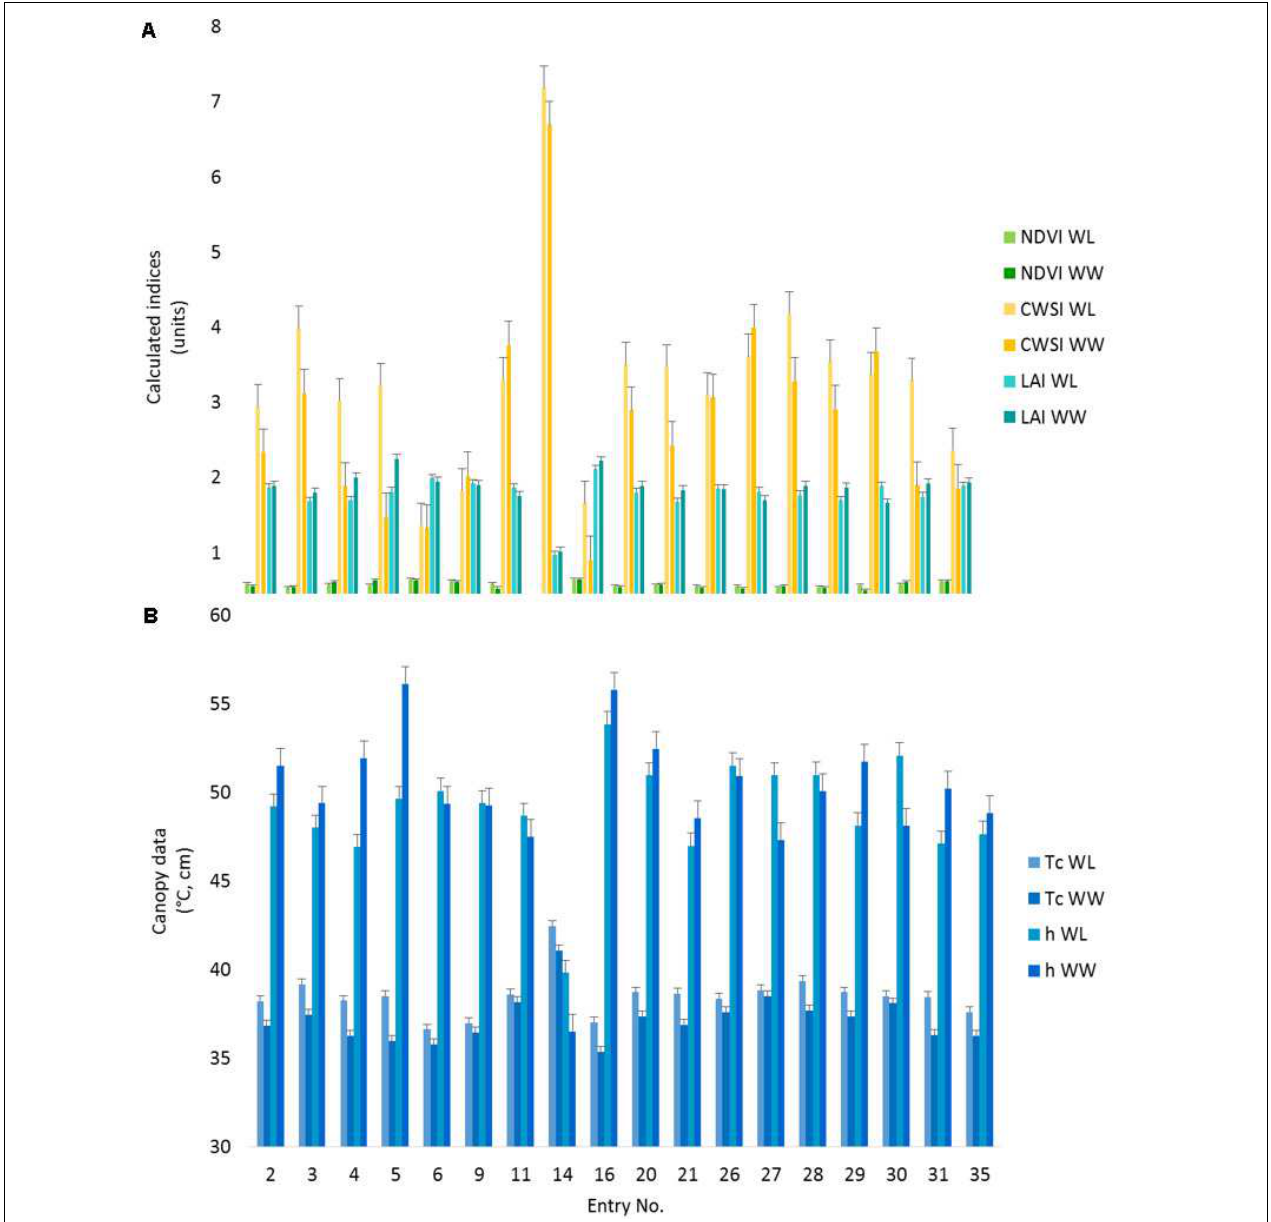
FIGURE 5 | Proximal sensing cart-derived phenotypes split out by irrigation treatment for each of 18 selected cotton entries. The data represent the lsmeans of each phenotype from the repeated measure analysis for the designated treatment and cotton entry. (A) The NDVI, CWSI, and LAI data are presented as calculated index units with corresponding error bars. (B) The canopy temperature ( Tc ) and canopy height ( h ) with the corresponding error bars. Entry number 35, the local check, was used as the control for all statistical